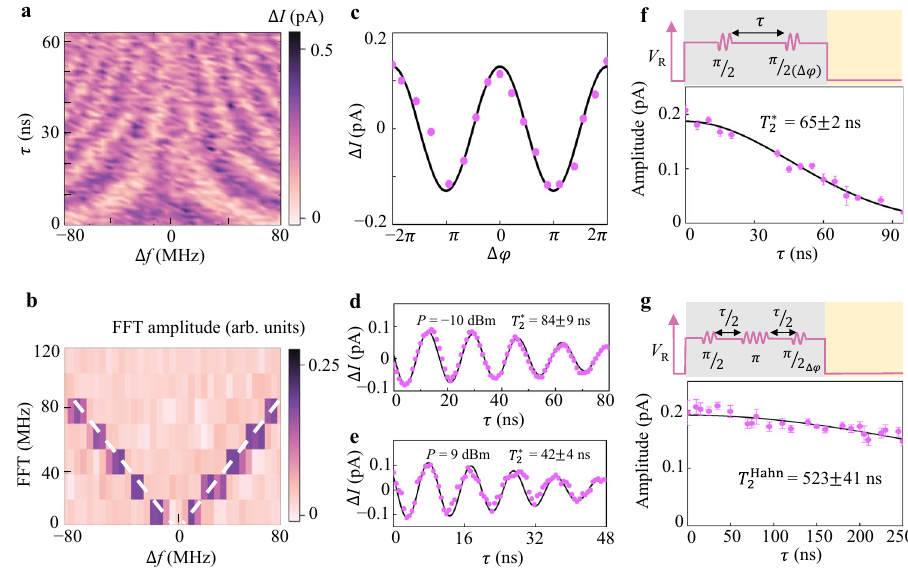
Fig. 3 Free evolution and dephasing of the qubit. a Ramsey fringes measured via transport current for mode A as functions of the driving microwave frequency detuning Δ f and free evolution time τ between two π /2 pulses at microwave power P = − 10 dBm, Larmor frequency f = 7.92 GHz and magnetic fi eld B = 100 mT, where the second pulse has the form of E ac cos(2 π f + Δ φ ). b Frequency FFT corresponding to the Ramsey fringes in a . Two white dash lines mark the dependence of z -axis rotation on the frequency detuning Δ f . When Δ f = 0, f Ramsey = 0 as well, corresponding to a pure dephasing process. c Oscillations of the phase control of the second pulse at τ = 0 ns and Δ f = 0 MHz shows a perfect cycle of 2 π . When performing ; π and 3 π Ramsey experiment at the condition of Δ φ = 0, π , the second pulse induces a rotation around the x , y , - x and – y axis, respectively. d , e Dephasing 2 2 ¼ 84 ± 9 ns and T (cid:4) ¼ 42 ± 4 ns are obtained from the decay of Δ I extracted from Ramsey experiment with a fi xed Δ f by fi tting times for mode A at T (cid:4) 2 2 Þ exp ð(cid:3)ð τ = T (cid:4) Þ 2 Þ þ I = − 10 dBm and P = 9 dBm, respectively. f Pulse sequence used to control the free evolution of the qubit I ¼ A (cid:1) cos ð 2 π f τ þ φ 0 at P 2 0 ¼ 65 ± 2 ns at P = 0 dBm, f = 7.88 GHz, and B = 156 mT. g Hahn echo sequence (top). After the Hahn echo, (top). Dephasing time for mode B: T (cid:4) 2 dephasing time of the mode B qubit is extended to 523 ns. The duration of the pulses are t π /2 = 2.5 ns and t π = 5 ns. Here we use I ¼ A (cid:1) exp ð(cid:3)ð τ